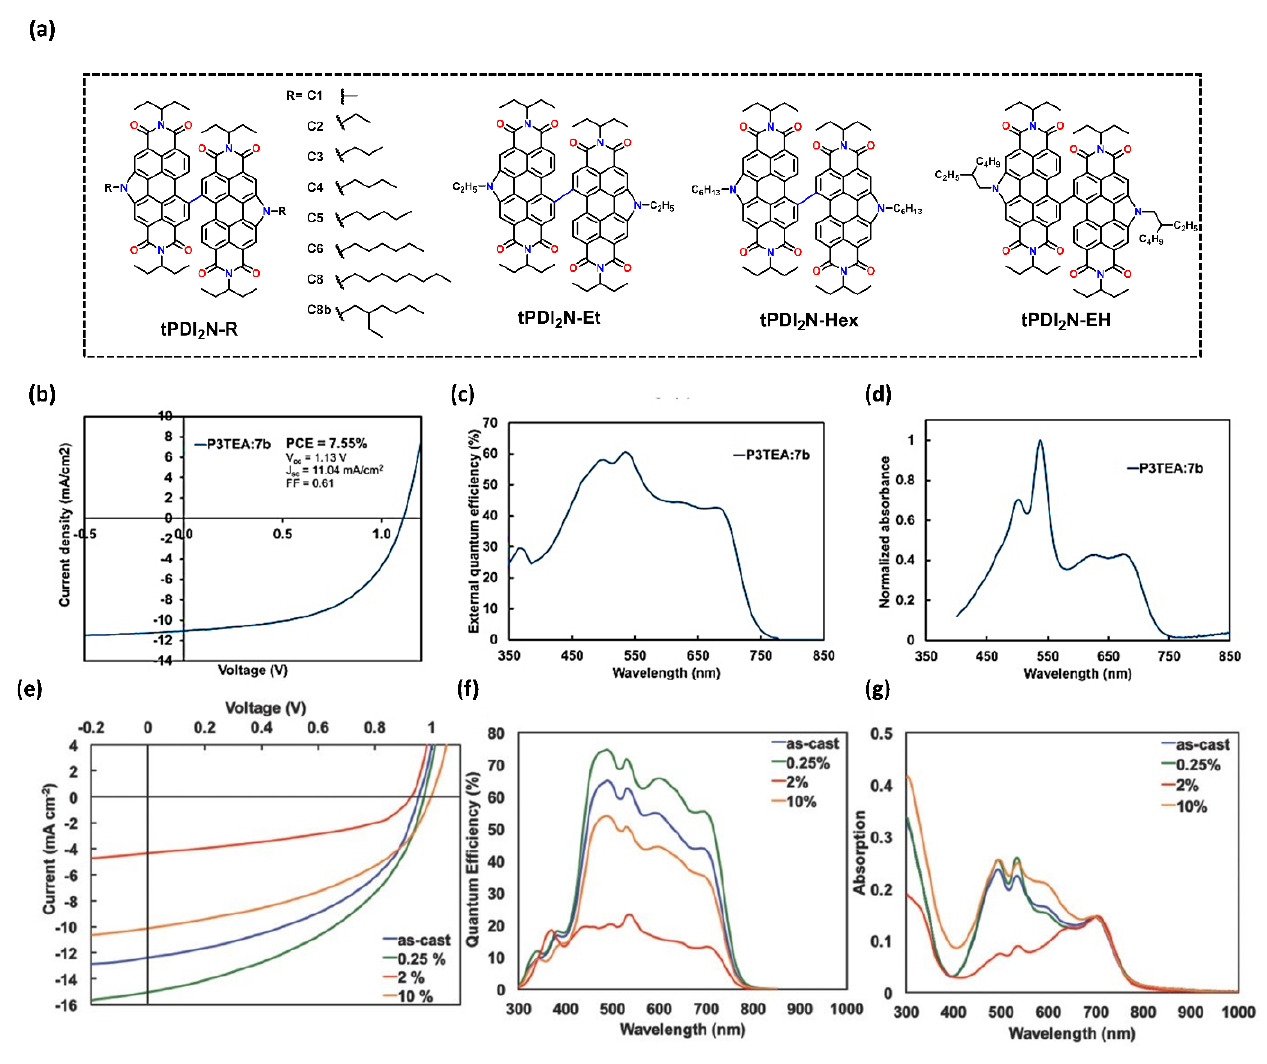
Figure 11. ( a ) Chemical structure of PDI dimers with various alkyl side chains ( b ) device J–V curves, ( c ) device EQE, and ( d ) UV–Vis absorption spectra of OPV devices based on a blend of P3TEA and 7b processed from 1,3,5-trimethyl benzene with 1,8-octane dithiol additive [81]. ( e ) device J–V curves, ( f ) device EQE, and ( g ) UV–Vis absorption spectra of OPV devices based on PTB7-Th: C8b blend films from 2Me-THF, as-cast and with different 1,8-diiodooctane (DIO) concentrations ( v / v %) [99]. Note that 7b = tPDI 2 N-Hex and C8b = tPDI 2 N-EH. ( b – d ), and ( e – g ) are reproduced with permissions from [81,99], respectively. Copyright 2016 Royal Society of Chemistry and 2018